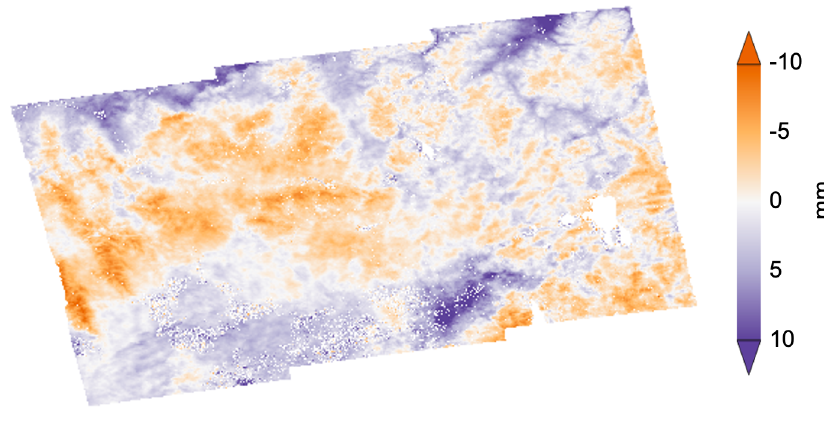
Figure A4. Track 122, Frame 141, 20170724-20170910.